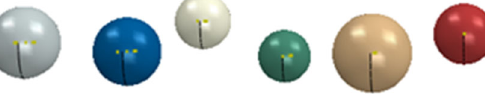
Figure 2. Diagram of random spheres.